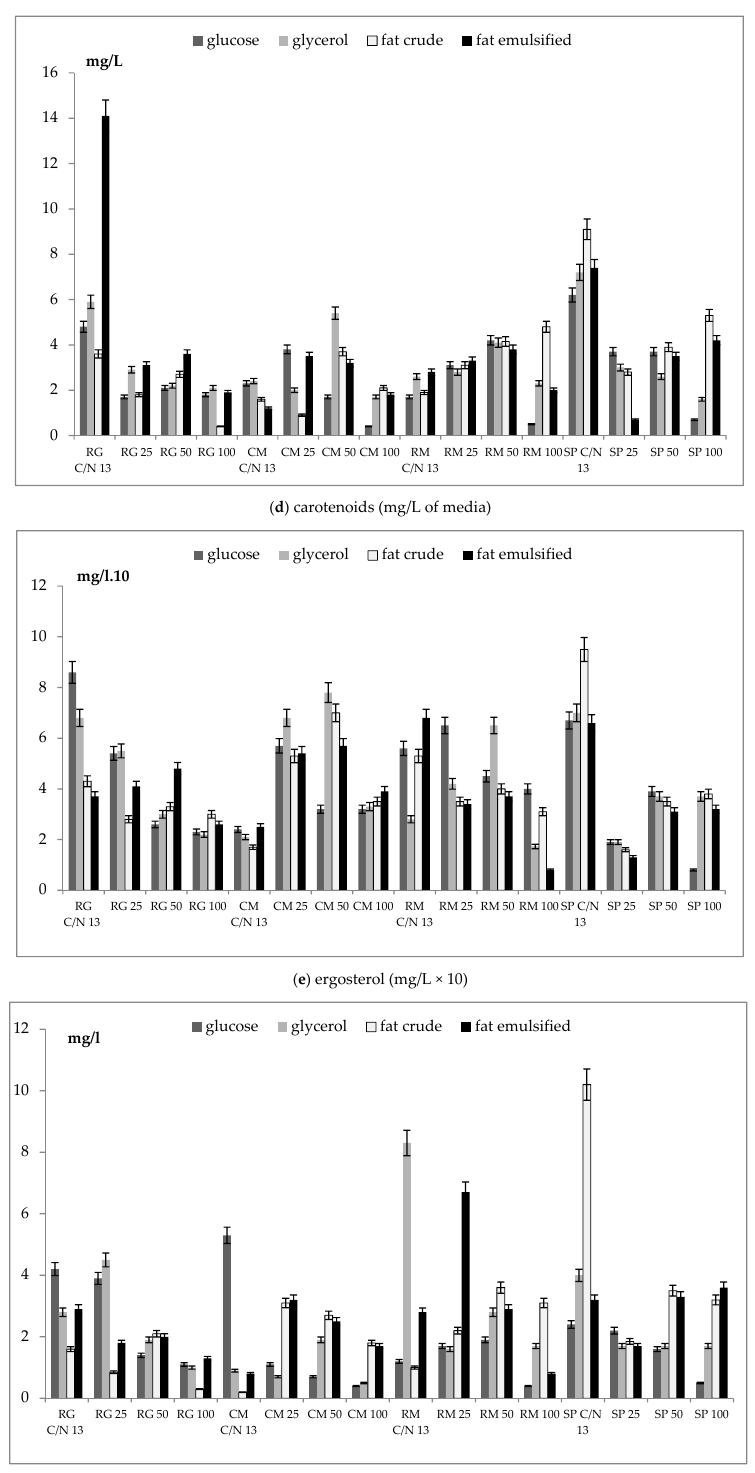
Figure 6. Production of biomass and metabolites at different C/N ratios. Changes of biomass production ( a ) in RG ( Rhodotorula glutinis ), CM ( Cystofilobasidium macerans ), RM ( Rhodotorula mucilaginosa ), and SP ( Sporobolomyces pararoseus ) in different media—glucose, glycerol, crude fat, emulsified fat; ( b ) Lipase production; ( c ) Lipids production; ( d ) Production of carotenoids; ( e ) production of ergosterol; ( f ) Production of ubiquinone. Abbreviations: RG ( Rhodotorula glutinis CCY 20-2- 26), CM ( Cystofilobasidium macerans CCY 10-1-2), RM ( Rhodotorula mucilaginosa CCY 19-4-6), and SP ( Sporobolomyces pararoseus CCY 19-9-6).